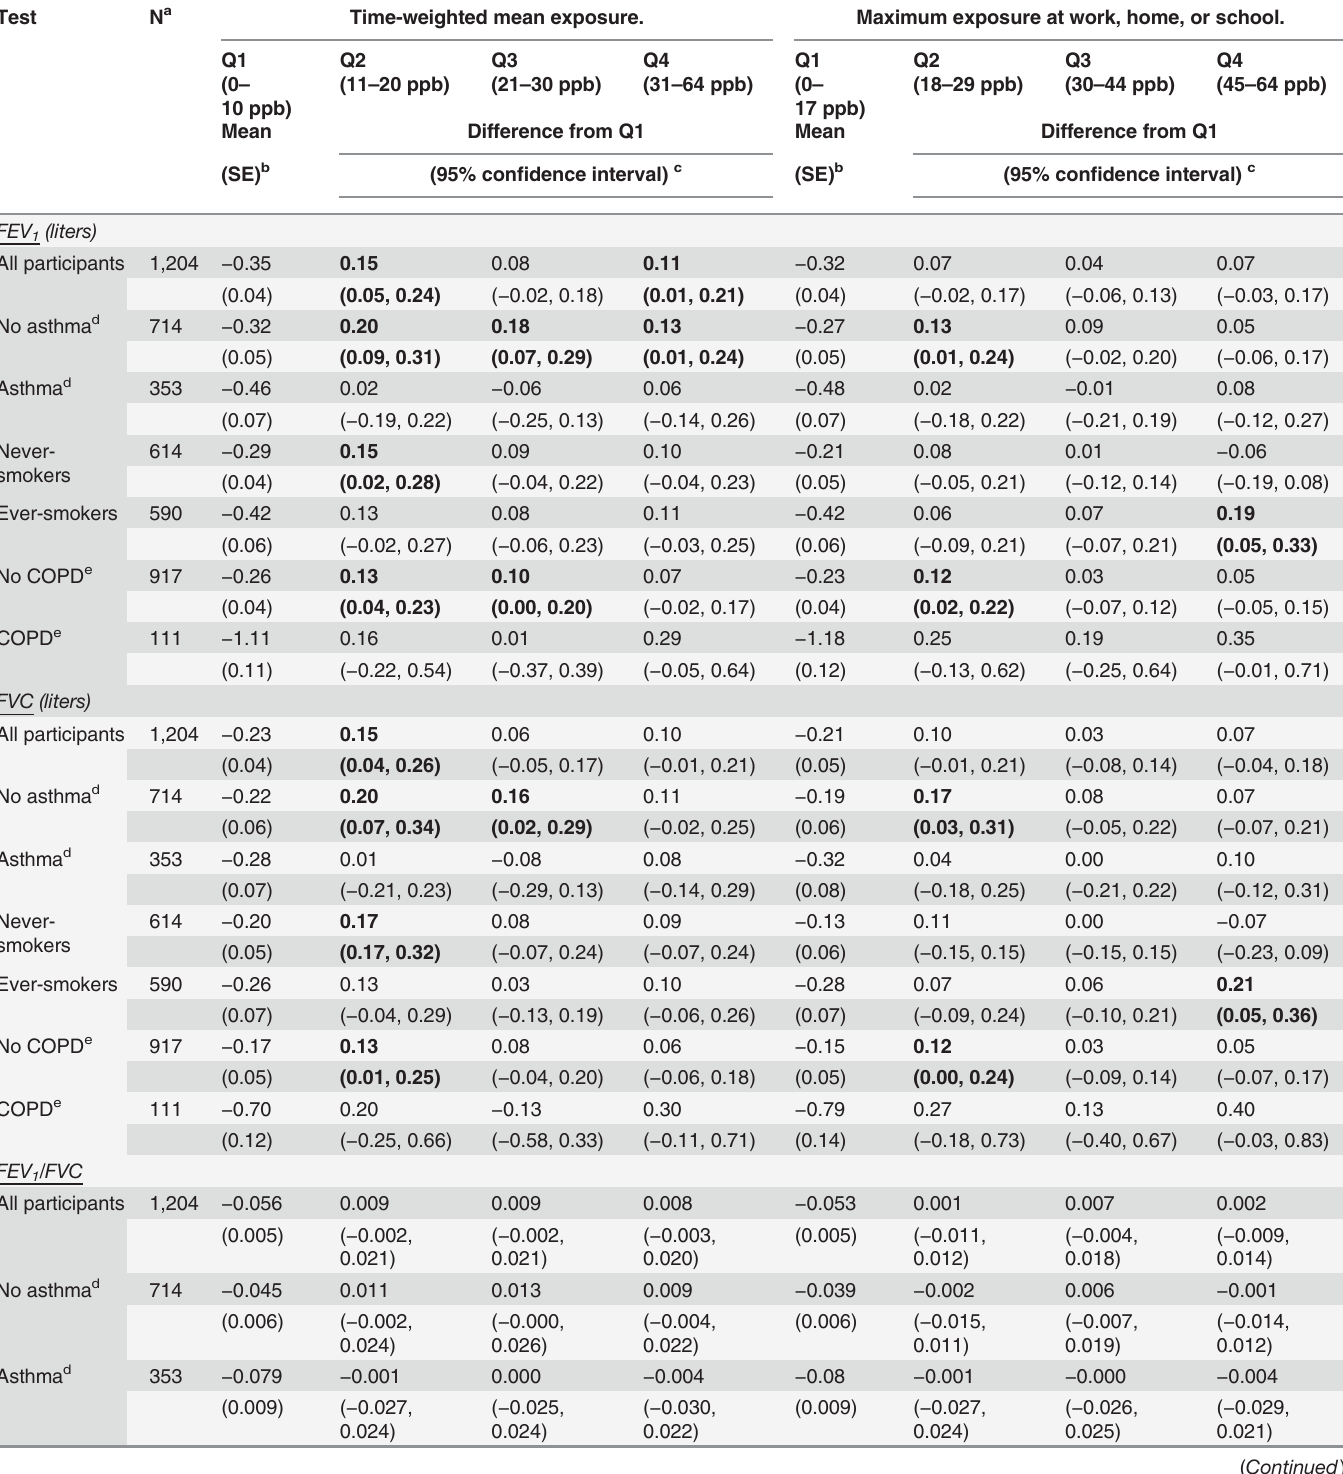
Table 3. Linear regressions of differences between observed and expected spirometric parameters (pre-bronchodilator spirometry results), show- ing adjusted differences from the first quartile (Q) of current H 2 S exposure concentration in ppb, after controlling for covariates. Test N a Time-weighted mean exposure. Maximum exposure at work, home, or